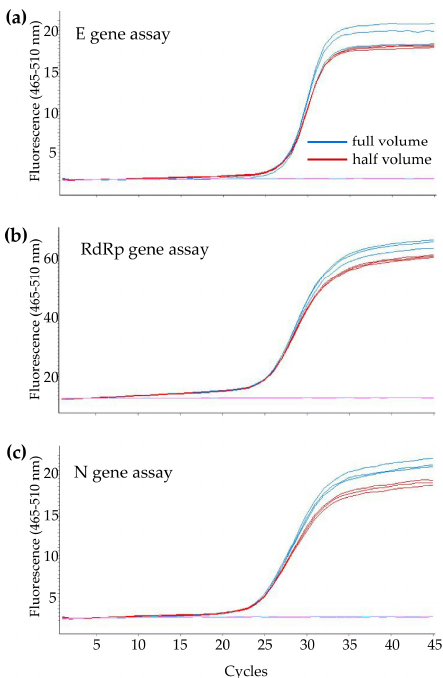
Figure 1. Example for amplification curves of the ( a ) E gene assay, ( b ) RdRp gene assay, and ( c ) N gene assay with full-volume (blue curves) and half-volume (red curves) reagents.